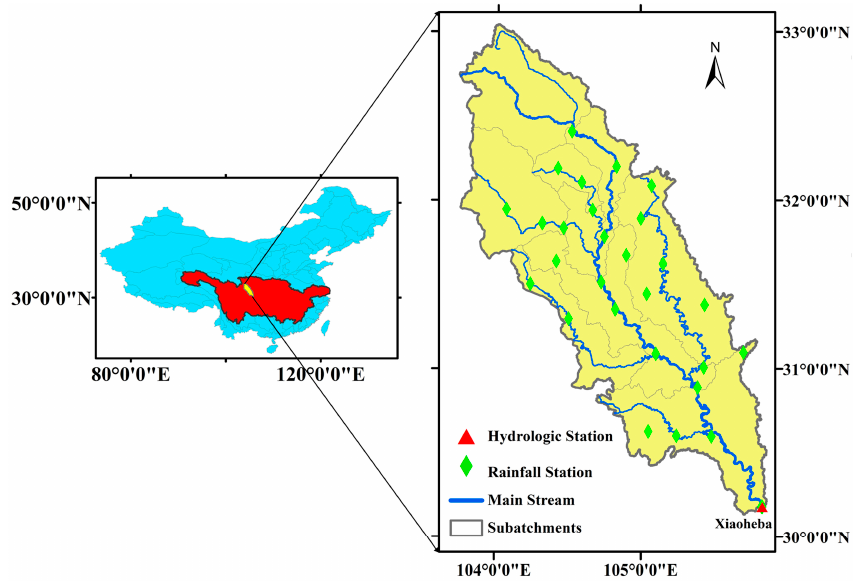
Figure 1. The location of the Yangtze River basin is shown in red and the Fu River basin in yellow ( left ); the general situations of the Fu River basin ( right ). Table 1. Meteorological ensemble forecast systems used in this study.